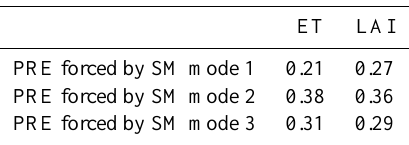
Table 6. Ratios of the global-scale forced variance over the total variance resulting from the application of the CM technique be- tween the first three modes of PRE forced by SM and the total fields of ET and